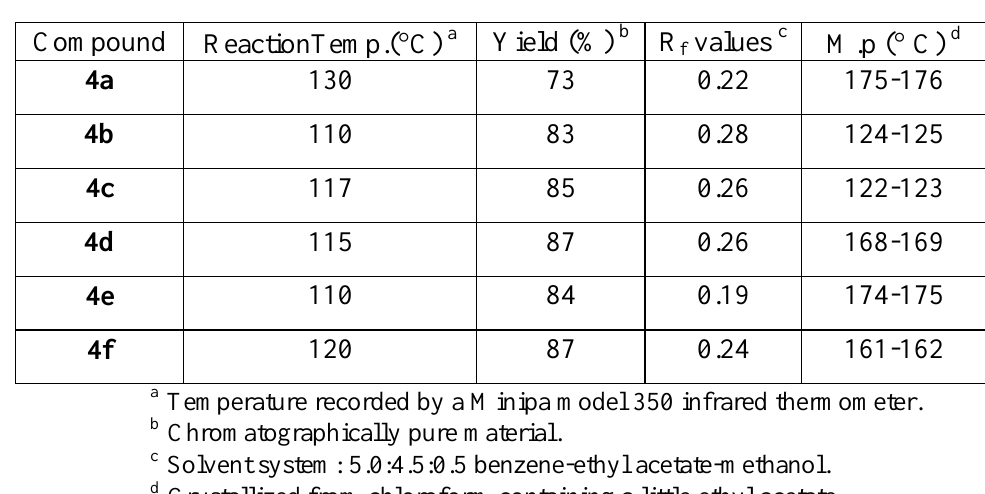
Table 1. Observed experimental results for the synthesis of 4a-f